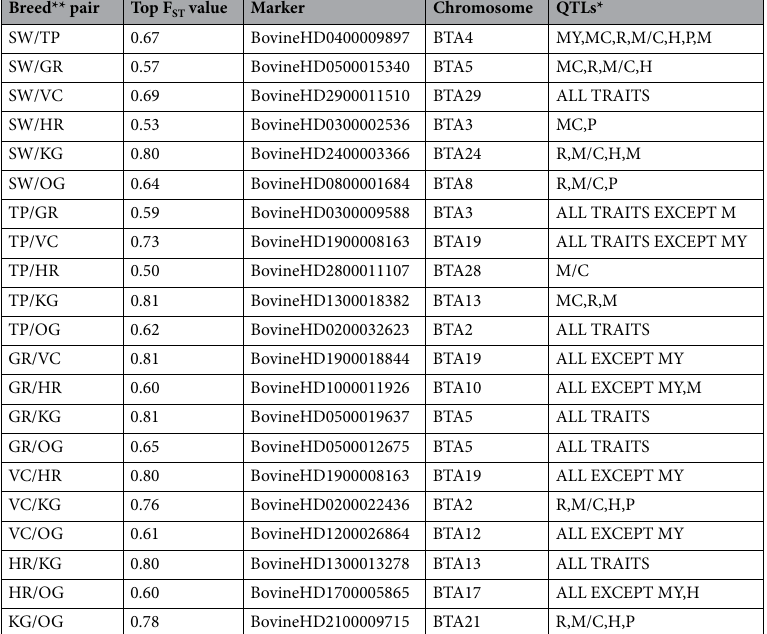
Table 6. The selection signature (F ST ≥ 0.50) values among the different cattle breeds and their annotation with Bovine QTL database. * MY-Milk Yield, MC-Milk Composition, R-Reproduction, M/C-Meat & Carcass. H-Health, P-Production, M-Morphology. ** SW-Sahiwal, TP-Tharparkar, GR-Gir, VC-Vechur, OG-Ongole, KG-Kangayam,